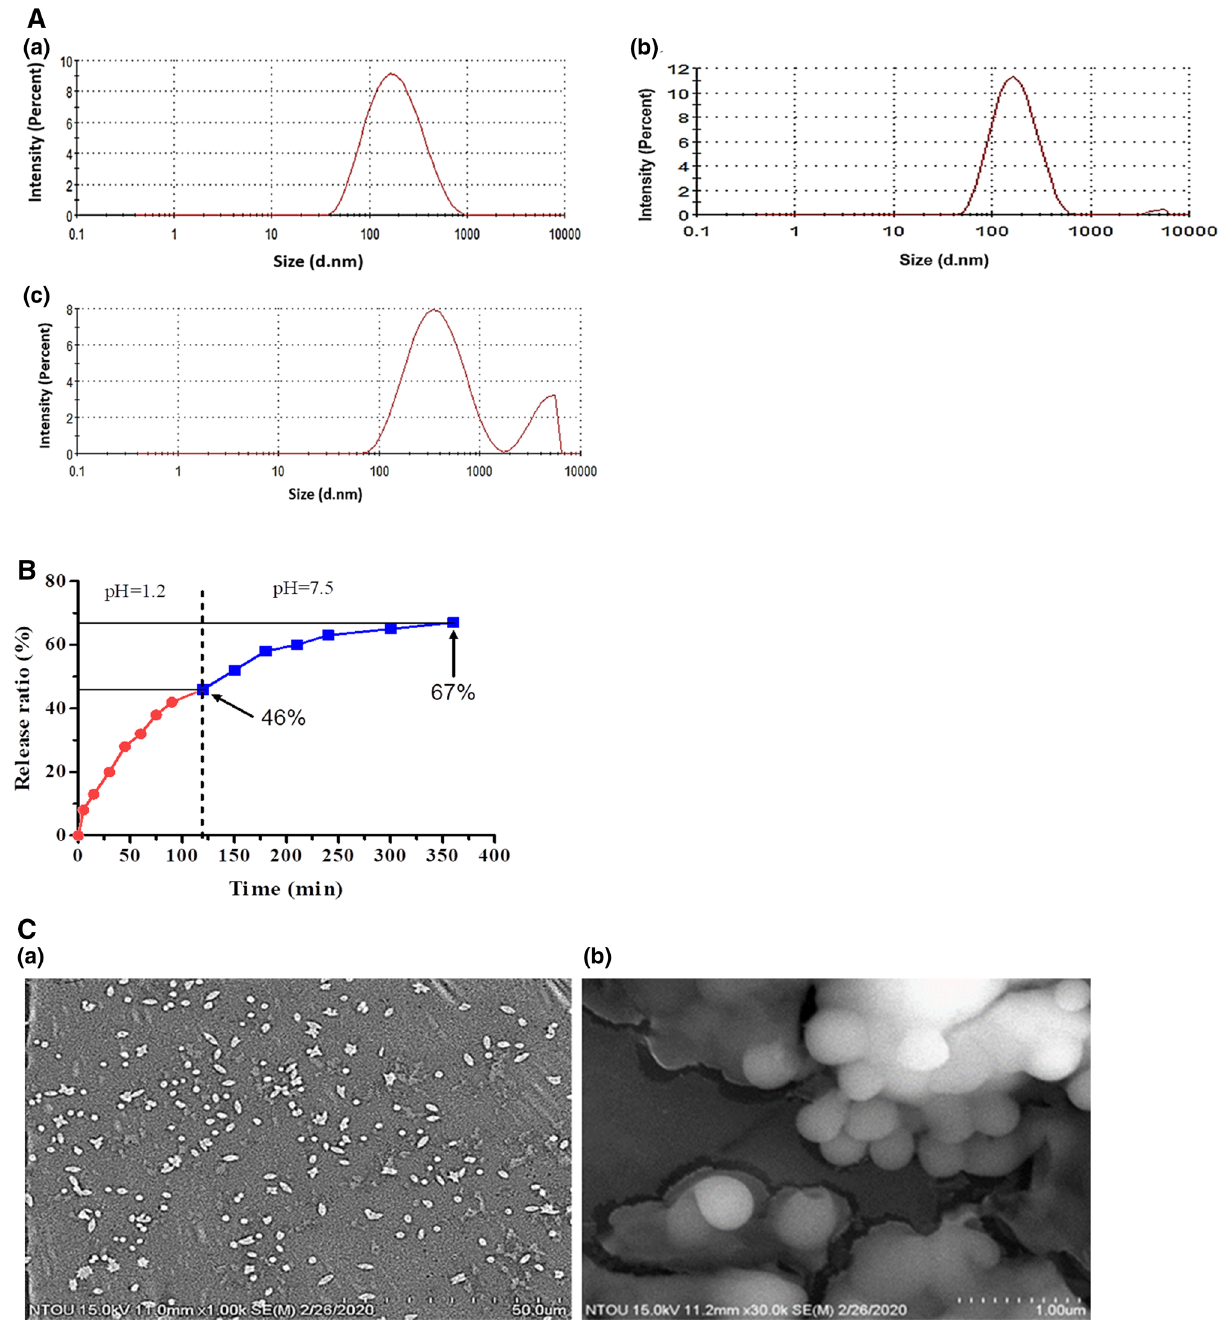
Figure 2. ( A ) Determination of ( a ) particle size distribution, ( b ) stability (after 3 months), and ( c ) stability (after 6 months) of Nano-EE by dynamic light scattering (DLS), ( B ) Drug releasing profiles of EE from Nano-EE in simulated gastric fluid (SGF) (red line) (pH = 1.2) and simulated intestinal fluid (SIF) (blue line) (pH = 7.5) by HPLC analysis, and ( C ) Scanning electron microscopic (SEM) images of Nano-EE at ( a ) 1000 times ( b ) 30,000